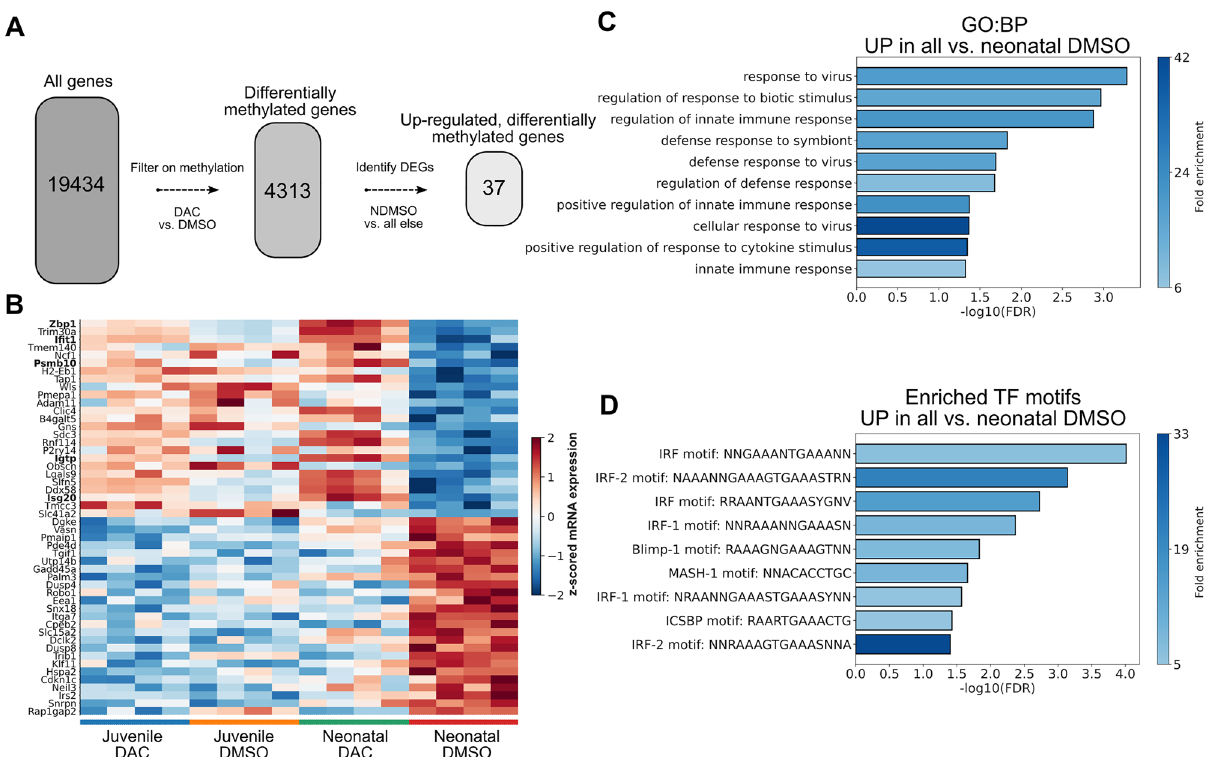
Figure 4. DAC treatment of neonatal mice infected with E. coli induces a juvenile-like immune response in CD4 + T cells. ( A ) Multi-level computational filtering overview. Genes were filtered to include only those that show a change in methylation state in response to DAC treatment in either age group. These differentially methylated genes were then ranked by their differential mRNA expression when comparing neonatal DMSO to all other groups. ( B ) Matrixplot of scaled mRNA expression levels for the top DEGs in each direction in the comparison of neonatal DMSO versus all else, generated with scanpy 28 . Bolded genes are directly involved in type-I interferon responses. Figure restricted to top 25 genes for visibility. ( C ) Over-Enrichment Analysis (ORA) of GO:BPs terms for the top DEGs identified in ( B ), showing over-representation of terms related to viral and bacterial defense responses. ( D ) ORA as in ( C ) for transcription factor (TF) motifs, showing over-representation of interferon response factor (IRF) motifs in the promoters of up-regulated